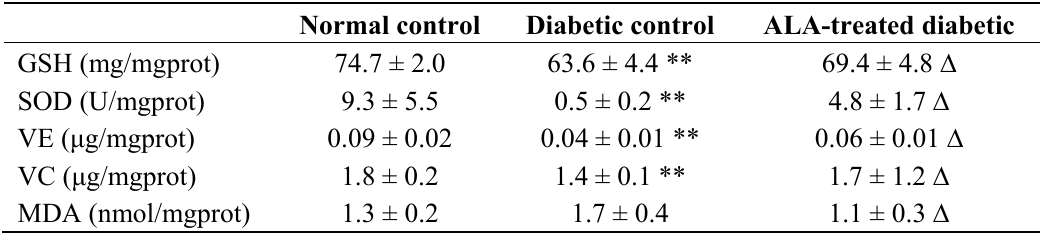
Table 4. Quantitation of glutathione (GSH), superoxide dismutase (SOD), Vitamin E, Vitamin C and malonaldehyde (MDA) levels in